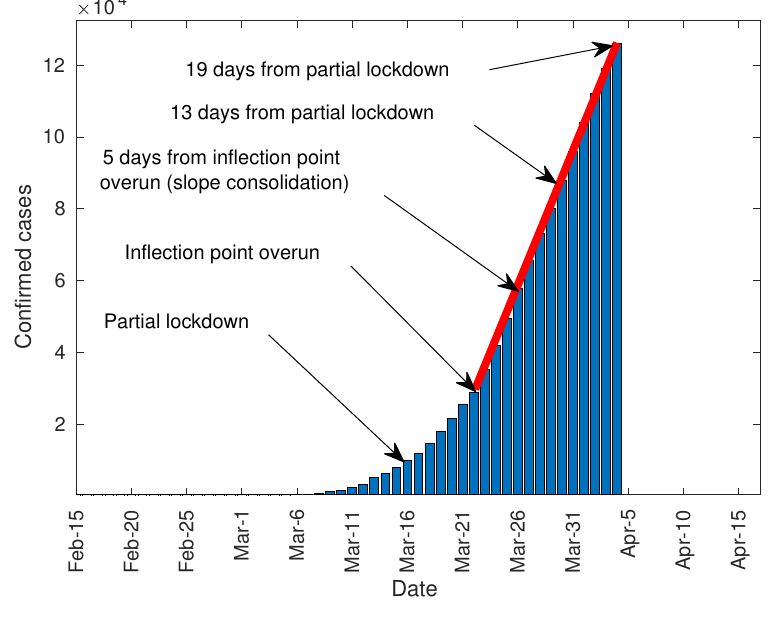
Figure 14. Slope determination for